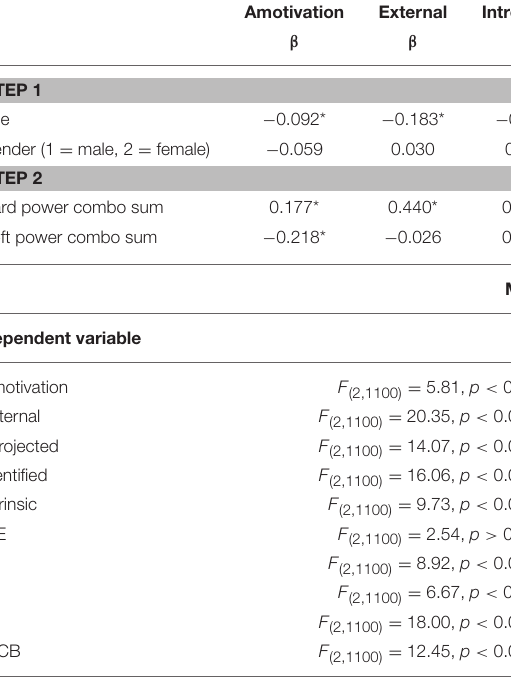
TABLE 8 | Study 2—combinations of power regression models, controlling for age and gender ( n = 1,103). Amotivation External Introjected